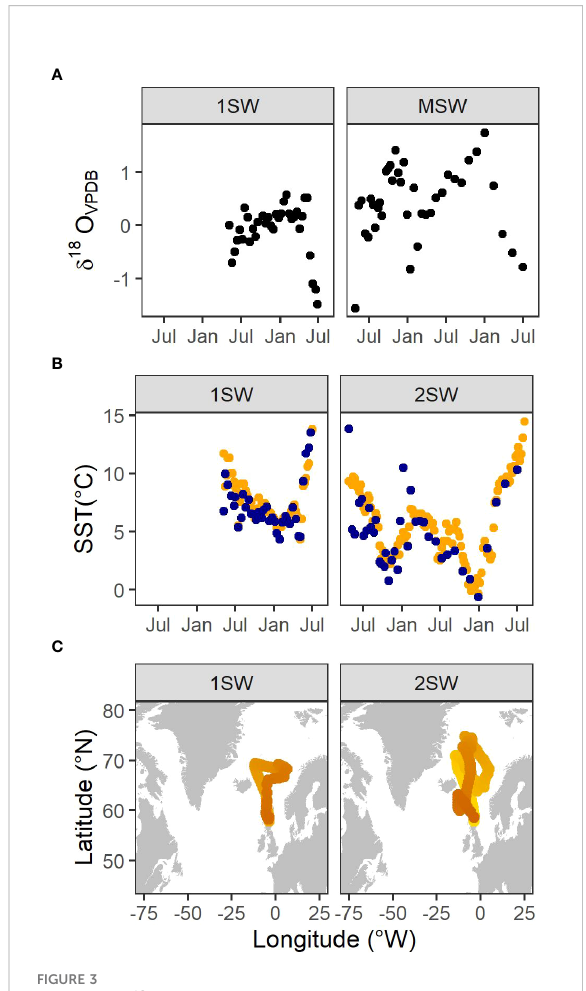
FIGURE 3 (A) Otolith d 18 O values along transects of wild Atlantic salmon (Salmo salar, L.) returning to Scotland. Pro fi les start at the transition to the marine phase and end at capture one or two sea-winters (1SW, 2SW, respectively) later. (B) SST values estimated from otolith d 18 O values (blue points) together with SST values extracted from the mean inferred location (orange points). (C) Mean locations inferred from the hidden Markov model. Lighter colour indicates the beginning of the